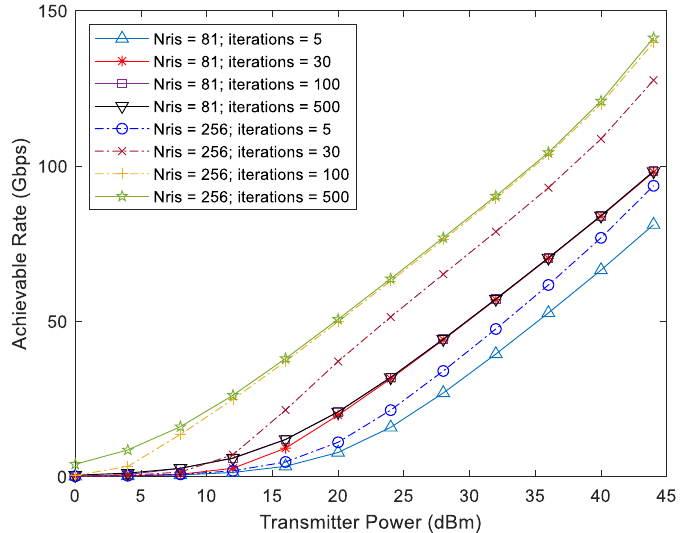
Figure 2. Achievable rate of the proposed APG versus power transmitted at the BS for different iteration values.